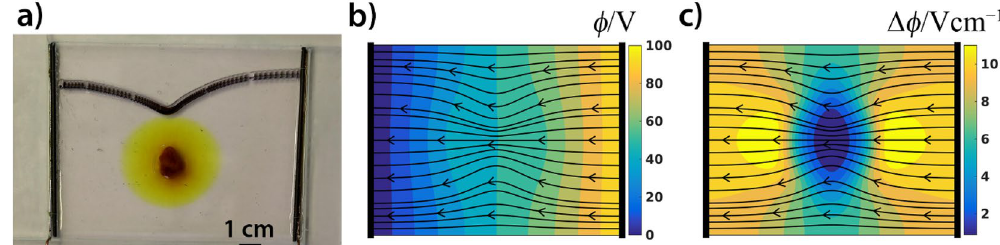
Figure 5. ( a ) Path deflection of a Hg droplet ( m = 200 mg) moving in an electric field using the galvanostatic condition ( I = 3.0 mA) between the parallel electrodes in a solution of sulfuric acid ( c = 25 mM). The domain was filled with distilled water and a piece of iron (III) chloride (FeCl 3 ) crystal was placed in the center of the container. The experiment started when the dissolved salt created a radially symmetric gradient of ions around the crystal. The depth of the solution in the domain was ~ 5 mm. The superimposed image shows the position of the droplet every 0.04 s. ( b ) The calculated electric field and ( c ) the magnitude of the gradient with the corresponding electric field lines.